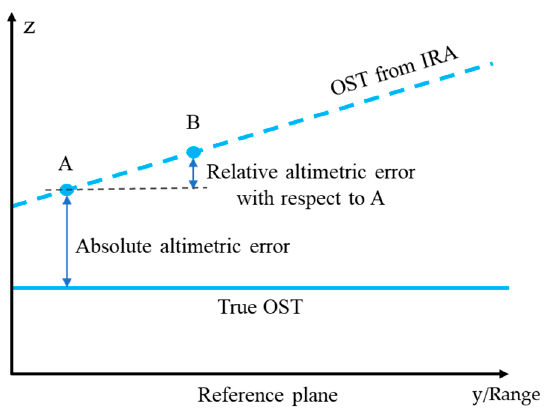
Figure 3. Schematic diagram of relative and absolute altimetric error.